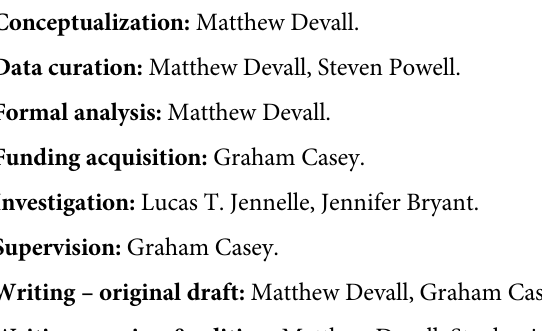
S1 File. Summary tables of differential expression and differential chromatin accessibility analysis. All pathway analysis was performed using Toppfun. Negative fold changes are associ- ated with increased accessibility or expression in ethanol treated